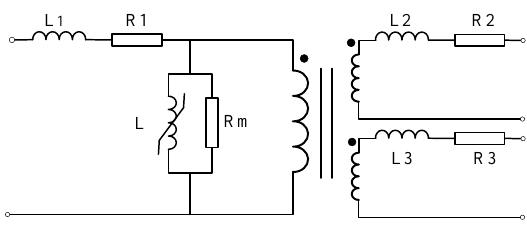
used to simulate the CVT grid-connected operation. The saturable transformer model in Simulink is shown in Figure 3. Figure 3. Saturable transformer model in Simulink.